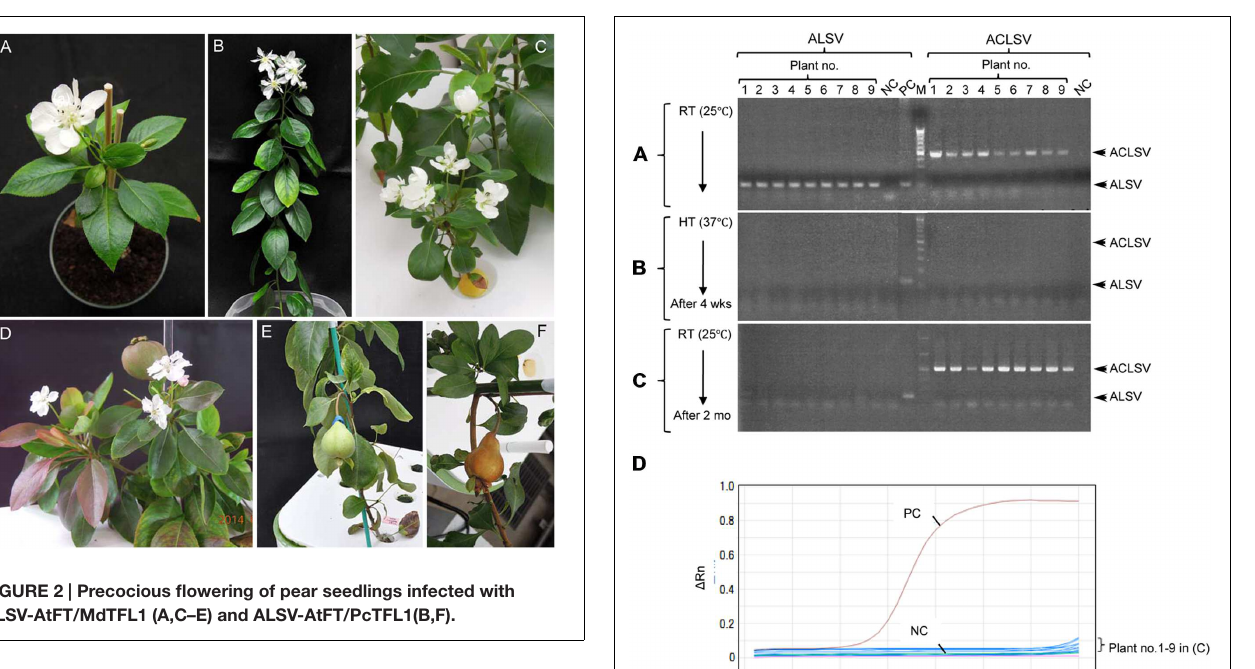
4 weeks detected neither of the viruses ( Figure 3B , Table 3 ).